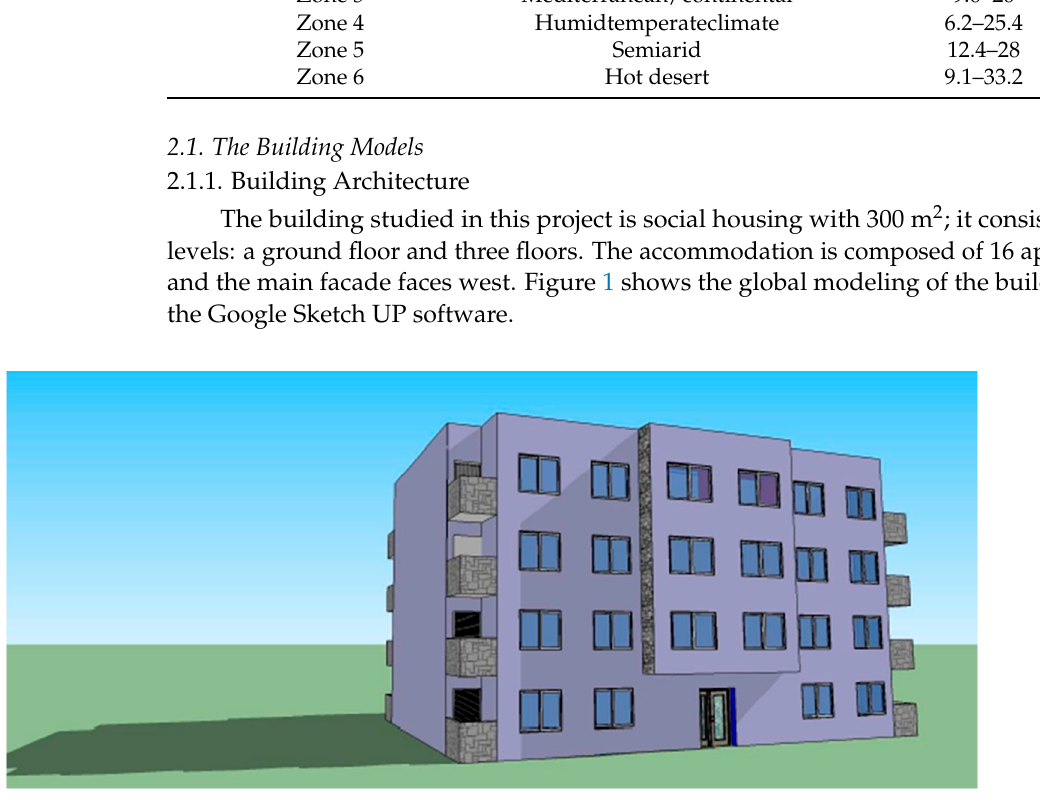
Figure 1. The building model with the Google Sketch UP software. Each floor of the building has four standard apartments of 70 m 2 , except the apart- ments on the ground floor, which are 60 m 2 in size. Figure 2 shows the architectural plan of the ground floor and a representative